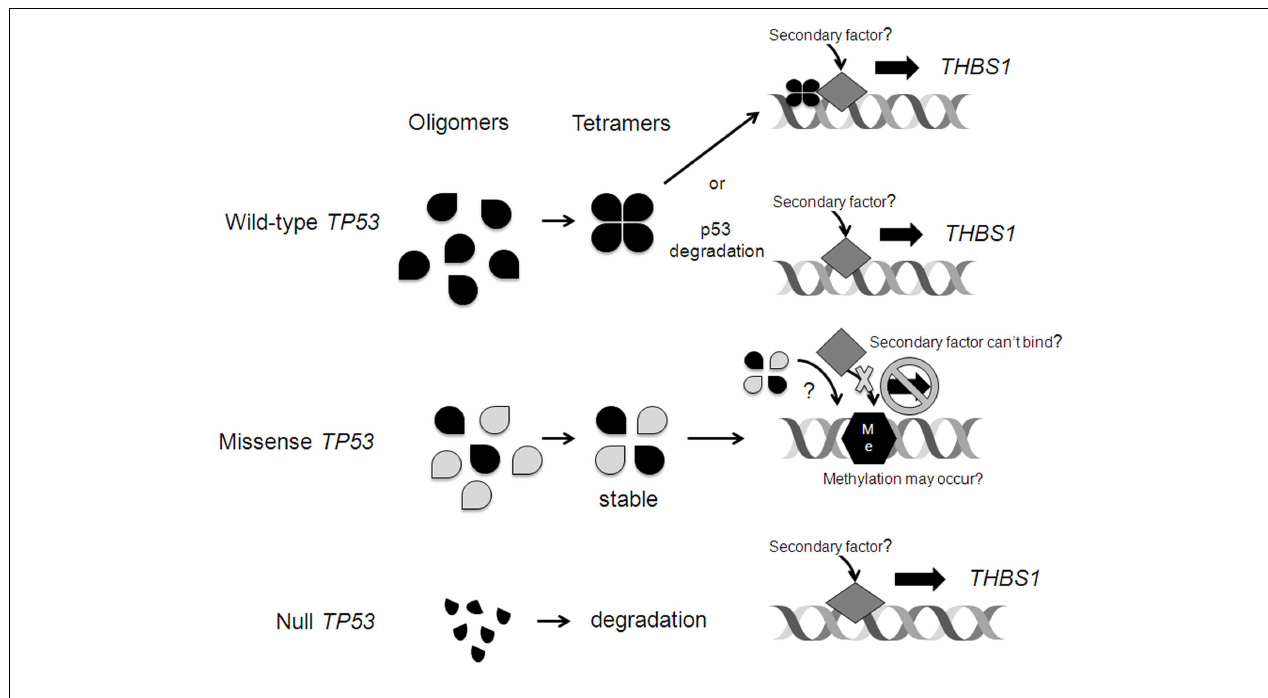
interaction with other secondary factors required to drive induction of transcription. In rare cases, upon mutation the wt p53 DNA-binding activity is lost and the p53 target regions are vulnerable to de novo cytosine methylation (Me) that inhibits transcription. Null TP53 mutations lead to complete loss of function of the gene and abnormal p53 fragments that are degraded.This may allow for a secondary factor to bind and induce THBS1